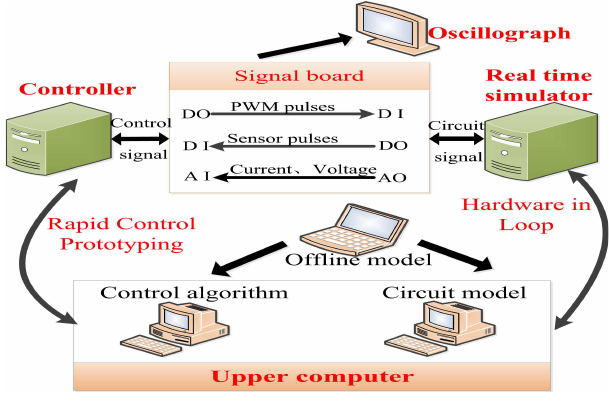
Figure 30. The structure of the experimental platform.